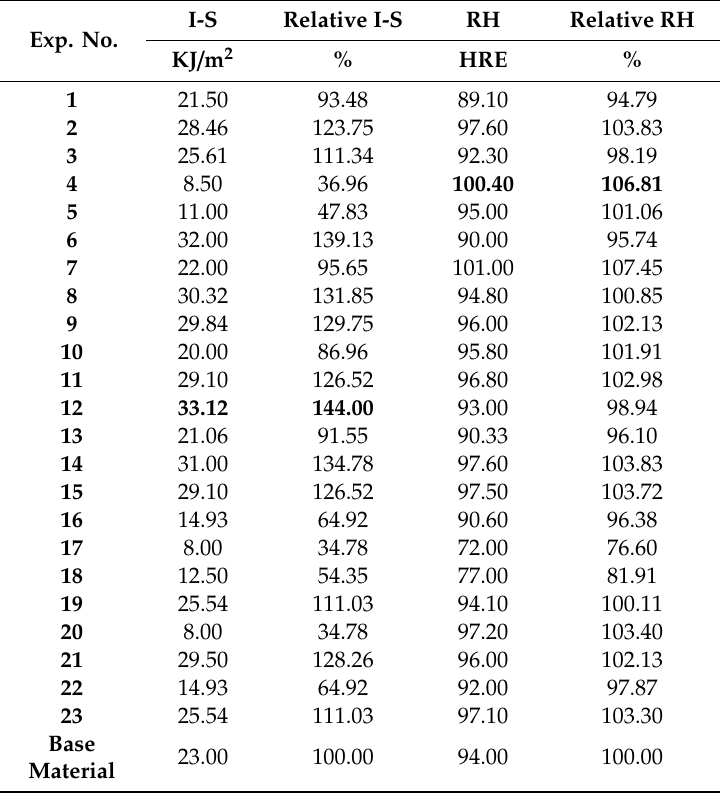
Table 4. Mechanical properties of the friction stir processed